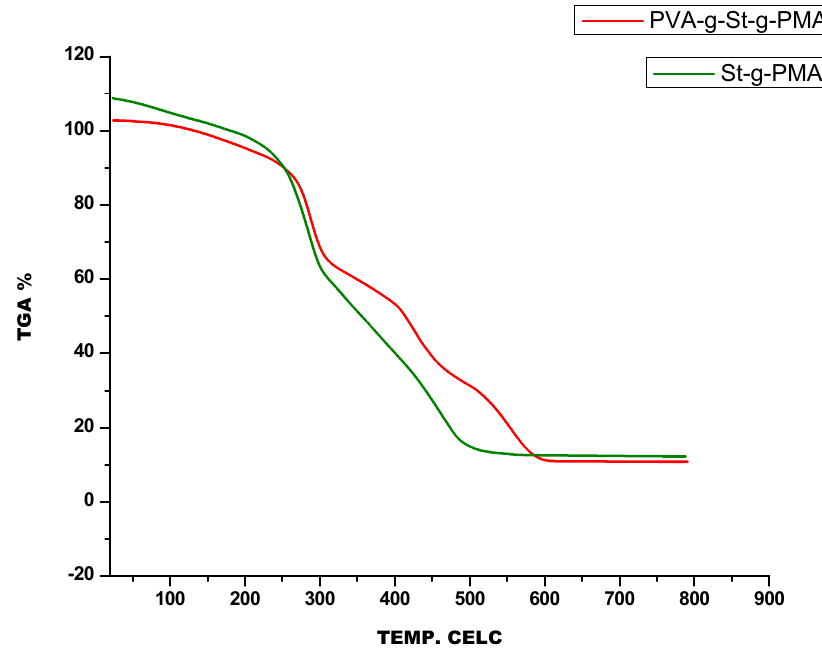
Figure 3. Comparative TGA graph of St-g-PMA and